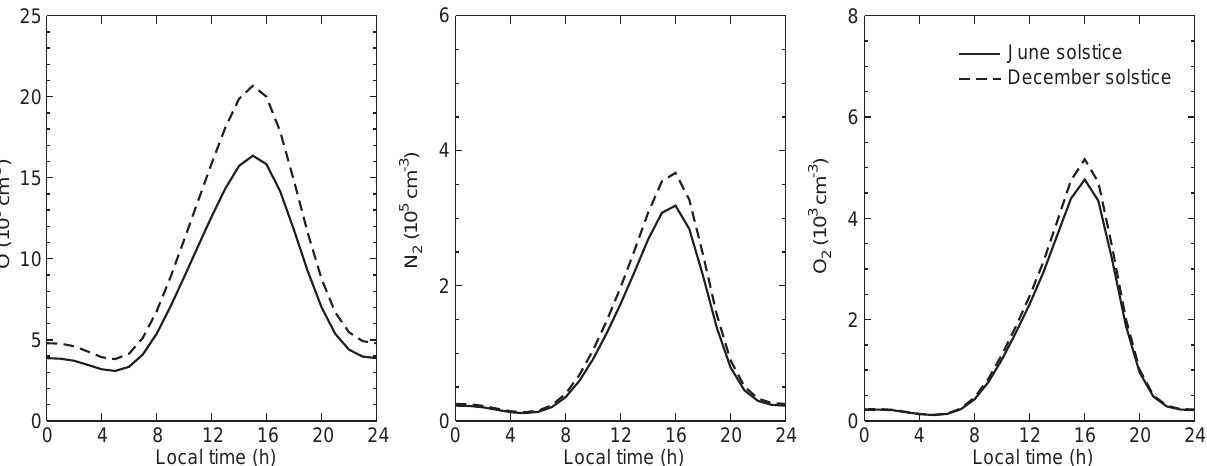
Fig. 7. Diurnal variations of the neutral gas (O, N 2 and O 2 ) densities averaged over the latitude range (cid:6) 25 (cid:14) for June solstice ( solid curves ) and December solstice ( dashed curves